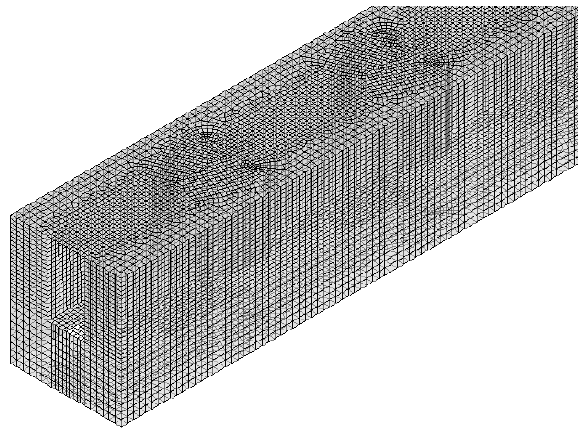
Figure 2. Mesh configuration of the solution domain.